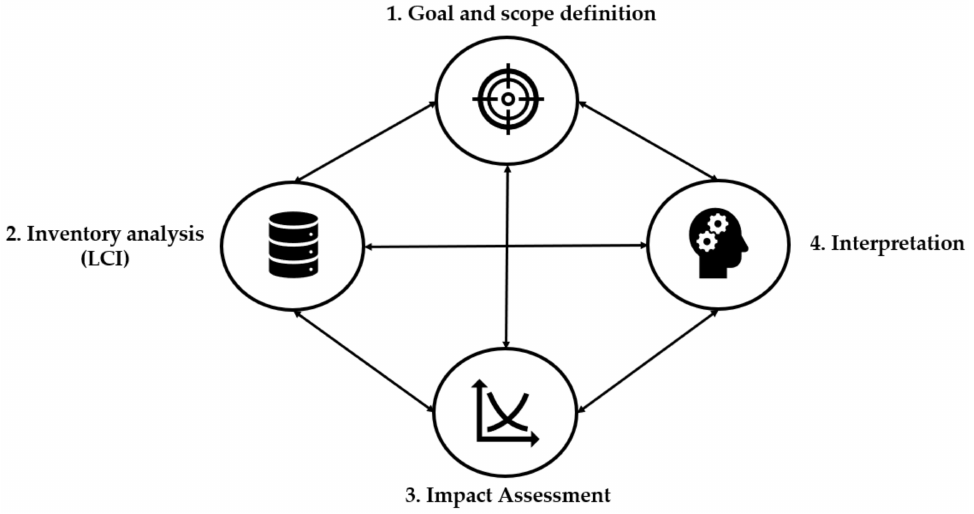
Figure 2. Main phases of a Life Cycle Analysis